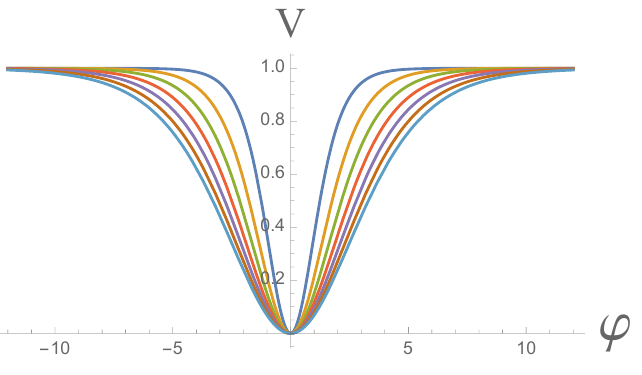
Figure 7 . T-model potentials for 3 (cid:11) = 1 ; 2 ; 3 ; : : : ; 7. The central (blue) line corresponds to the disk with 3 (cid:11) = 1. The third line from the center (green) corresponds to the conformal in(cid:13)ation model with (cid:11) = 1 [9]. The outer line shows the potential with 3 (cid:11) = 7. The value of the in(cid:13)aton (cid:12)eld ’ is shown in Planck units M p = 1; the height of the potential is shown in units of m 2